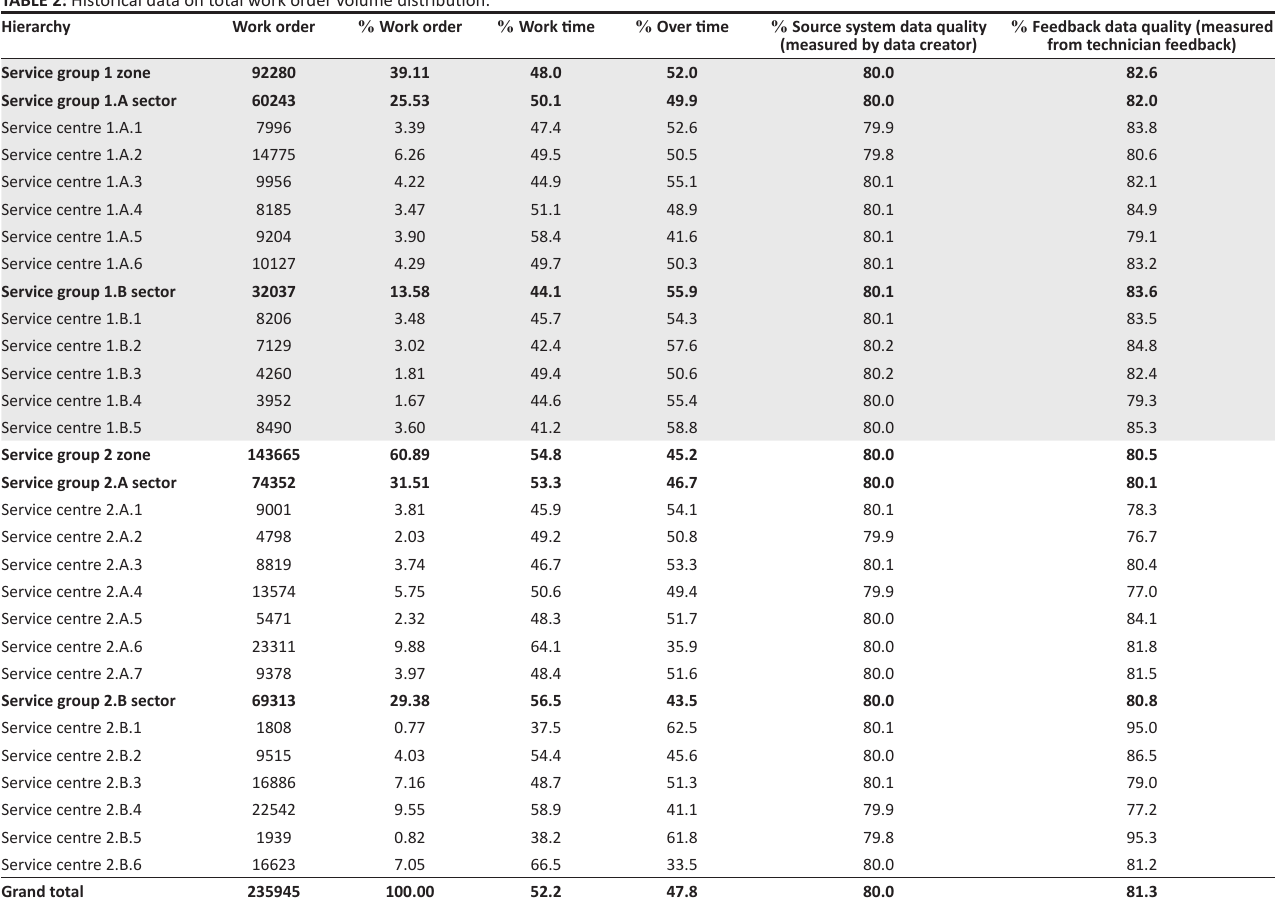
TABLE 2: Historical data on total work order volume distribution. Hierarchy Work